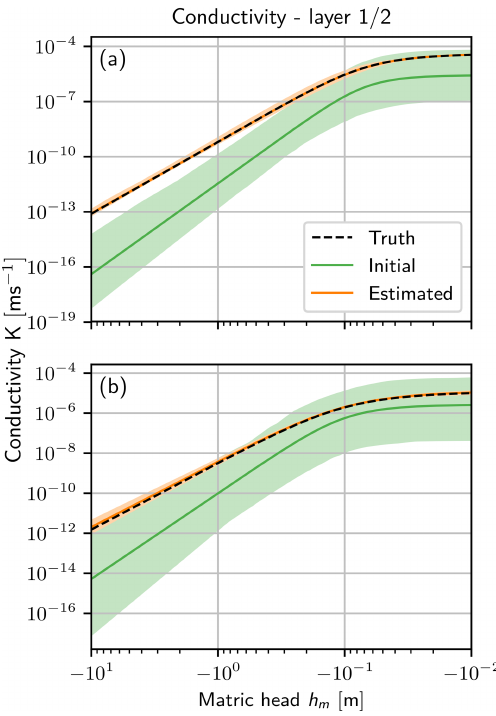
Figure 6. Conductivity function K(h m ) (Eq. 19) for (a) layer 1 and (b) layer 2. In this function all estimated parameters are repre- sented. The initial 95% quantile of the ensemble (light green) with the mean (green line) are shown. The truth (black dashed line) is al- most congruent with the estimated mean (orange line), so only the 95% quantile of the final ensemble (light orange) is visible.